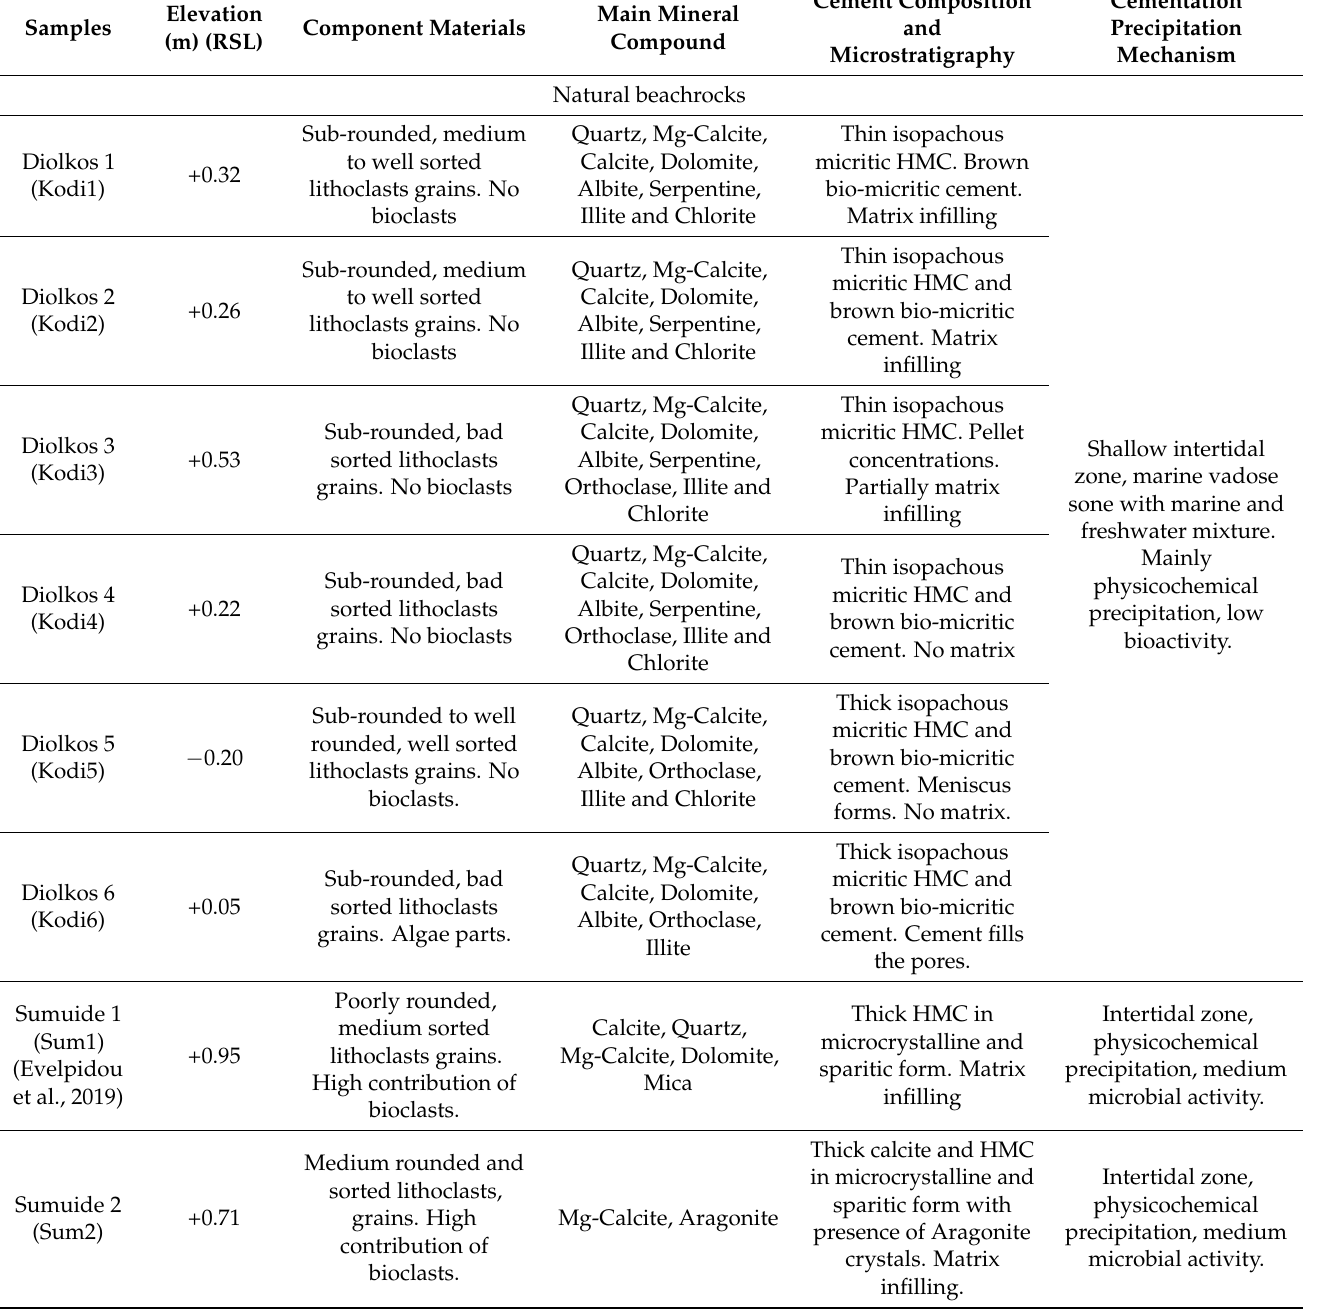
Table 3. Physico-chemical characteristics of natural beachrocks from Diolkos and Sumuide areas and their corresponding artificial beachrock. Their micromorphology is based on SEM and microscopic examination. Main mineral components were also confirmed by XRD analysis. Microcrystalline HMC was observed as main cement